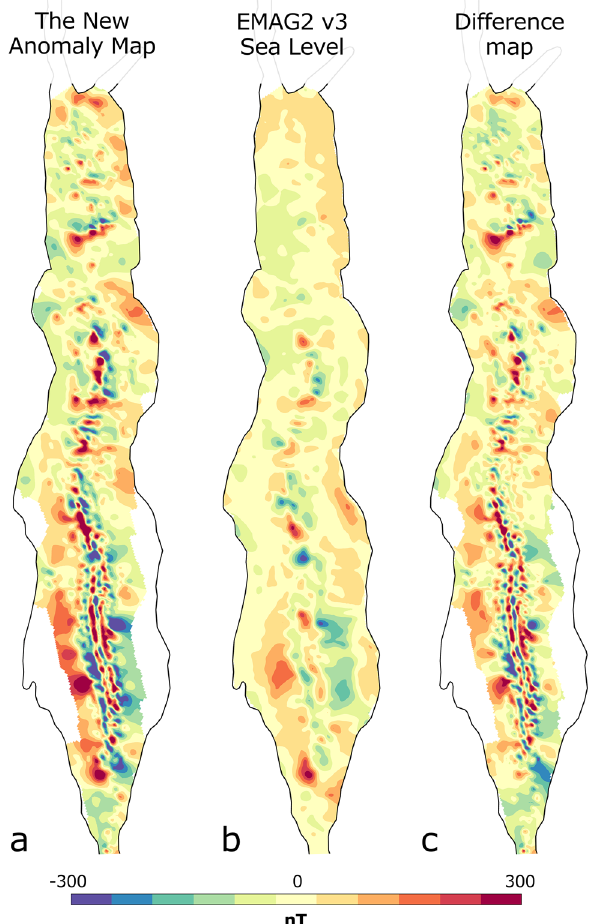
Figure 7. Comparison between ( a ) the new magnetic anomaly map produced in this study and ( b ) the EMAG2 v3 global compilation, and, the differences between them ( c ). The maps are presented with linear